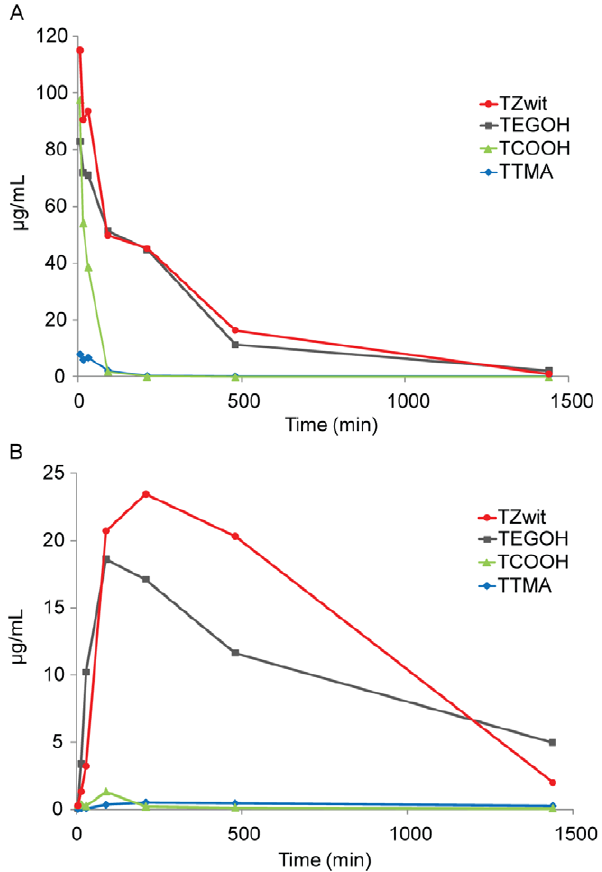
Figure 2. Plasma profiles for gold nanoparticles. Normal mice were injected either (A) intravenously or (B) intraperitoneally. Data points are the mean + / 2 SEM from n=3 animals.